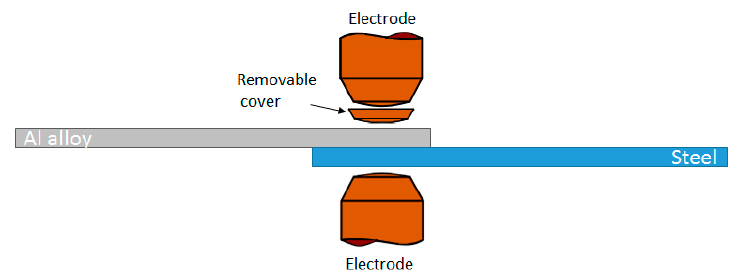
Figure 4. Resistance spot welding using a removable cover on the aluminum alloy side.